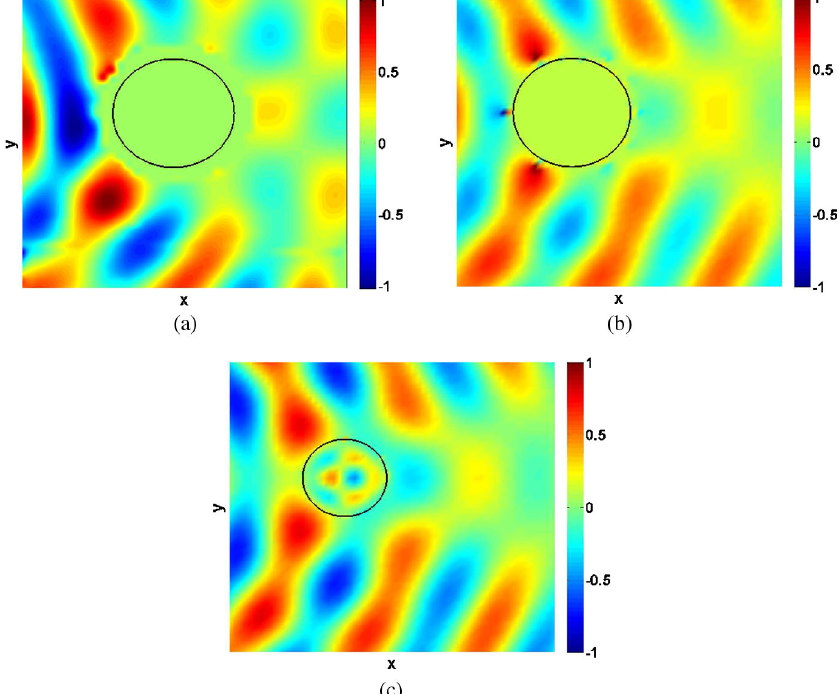
FIG. 12. (a) The measured real part of the total electric field, with the weights of the magnetic-dipole array set up to disguise the cylinder as a smaller dielectric cylinder. Note how the shadow region has changed. (b) The simulated total electric field found using COMSOL for disguising a PEC cylinder as a smaller dielectric cylinder. Note the good agreement with Fig. 12(a). (c) The simulated total electric field for a dielectric cylinder of radius r ¼ 0 : 4 (cid:1) and dielectric constant " ¼ 10 found using COMSOL